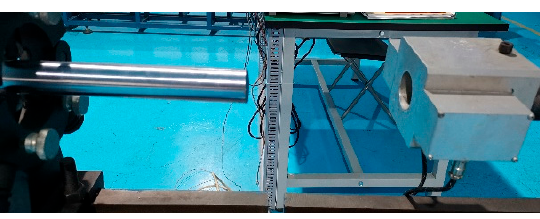
Figure 6. The picture of support end test.